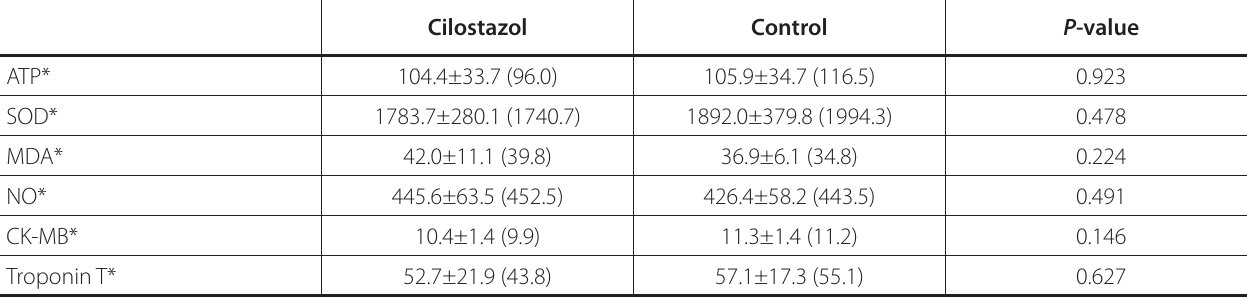
Table 2 . Comparison of biochemical markers between the cilostazol and control